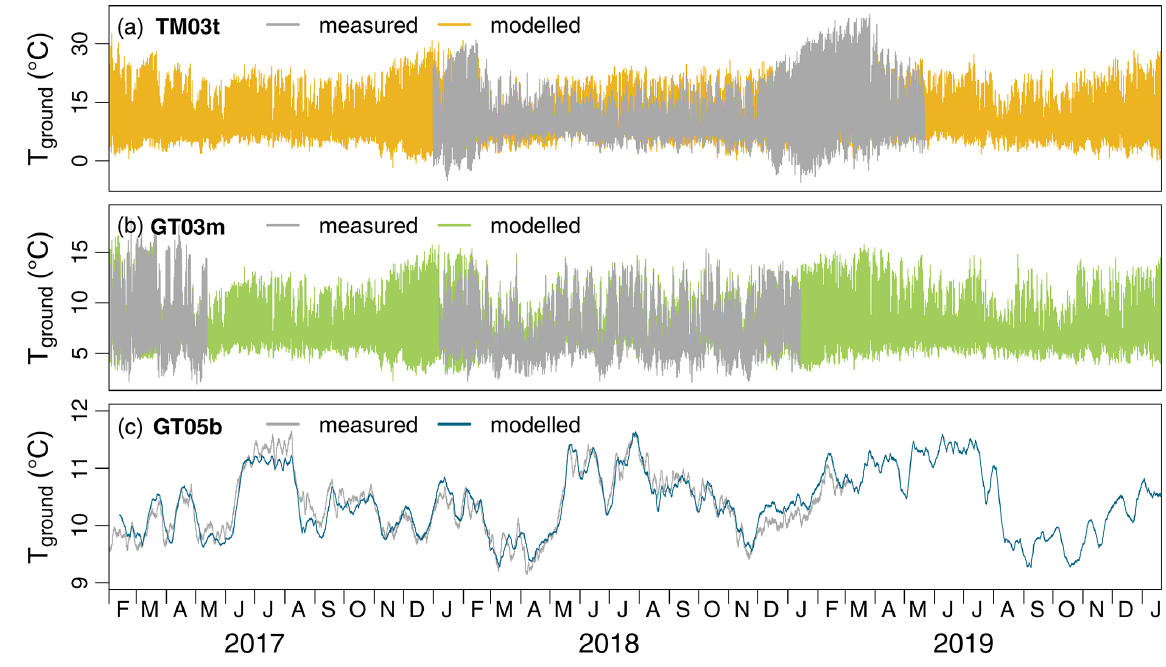
Figure B3. Examples of gap-filled hourly ground temperature time series at (a) 2cm, (b) 10cm, and (c) 50cm depth using a simple linear regression model and data from a logger in the vicinity. Please refer to Sect. 3.3 and the supplementary file “information_sheet_data_gap- filling.ods” (Sect. 6) for more details regarding the gap-filling